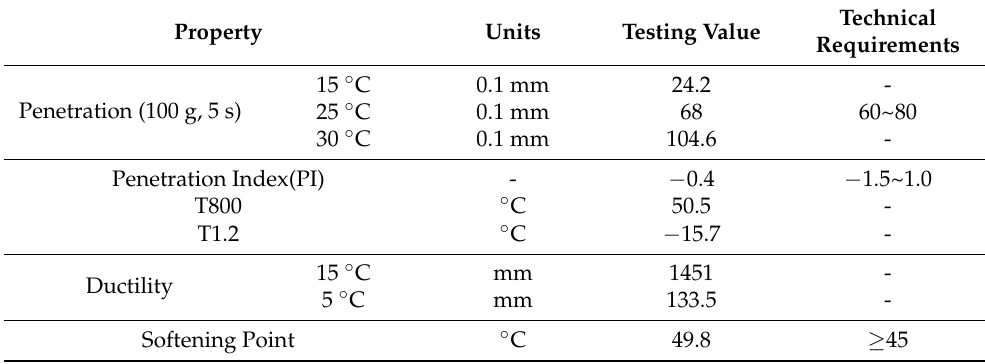
Table 1. Properties of virgin bitumen.